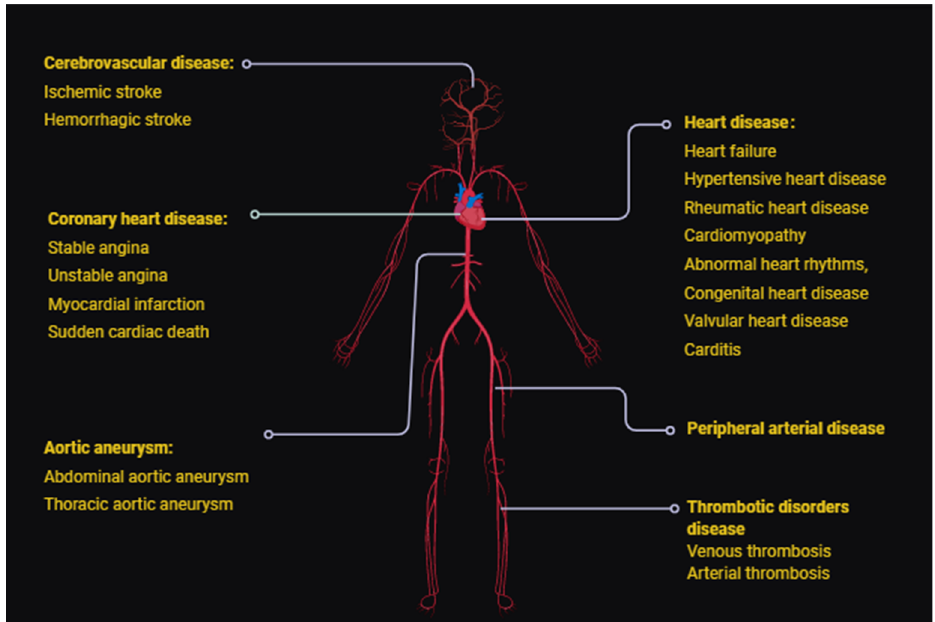
Figure 1. A schematic illustration of common types of CVDs including cerebrovascular disease, coronary heart disease, aortic aneurism, heart disease, peripheral artery disease, and thrombotic Dis- orders.